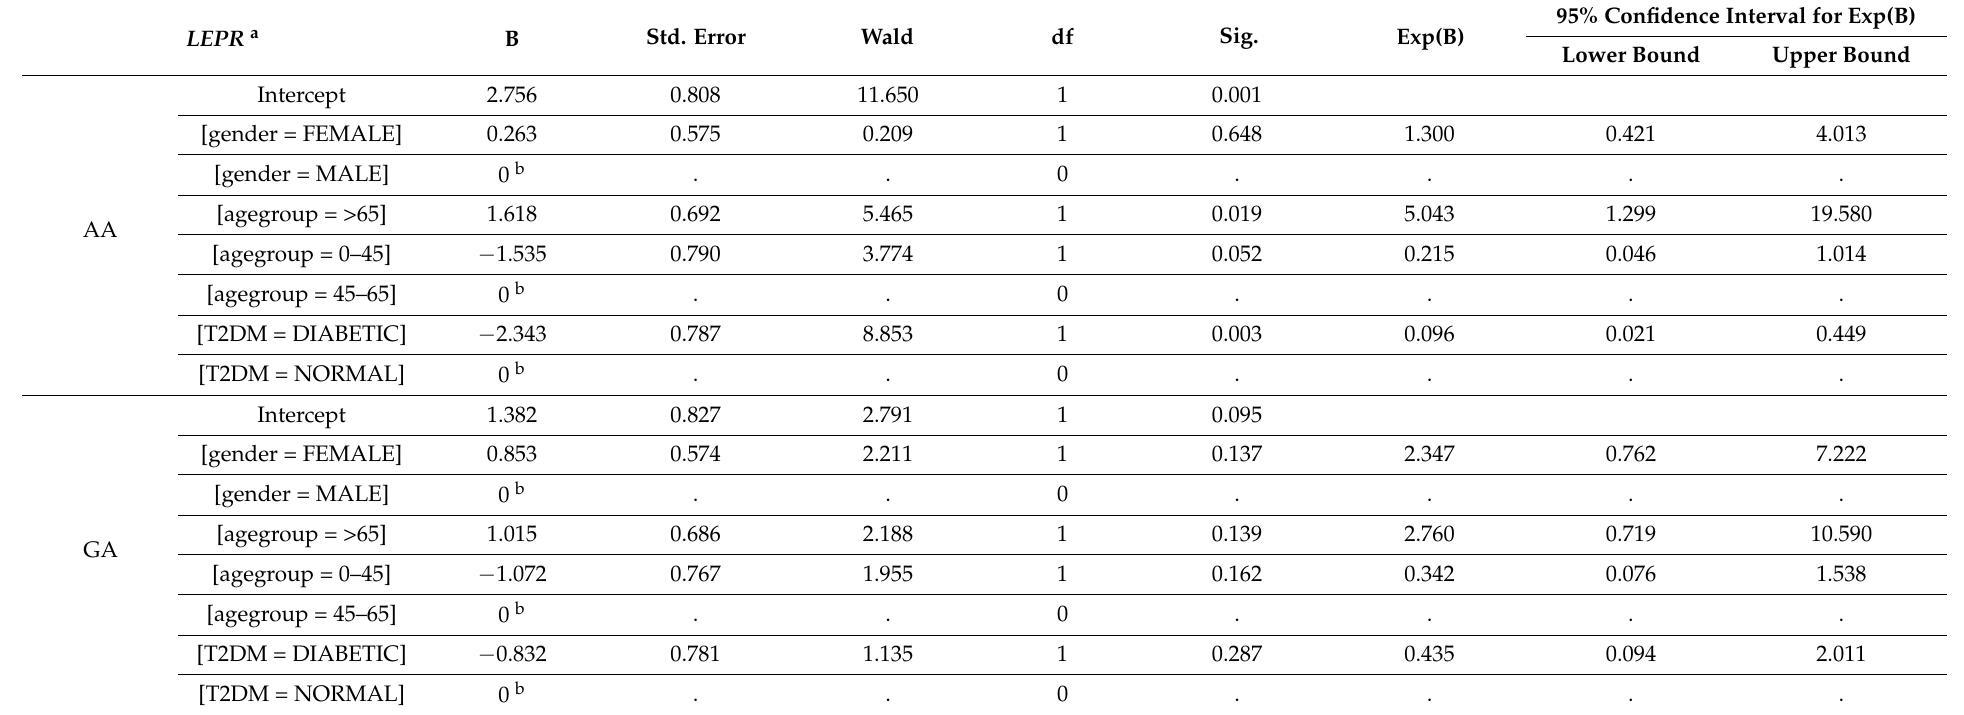
Table 8. Multinomial logistic regression analysis for the LEPR Gln223Arg genotypes. Parameter Estimates. LEPR a B Std. Error Wald df Sig. Exp(B)